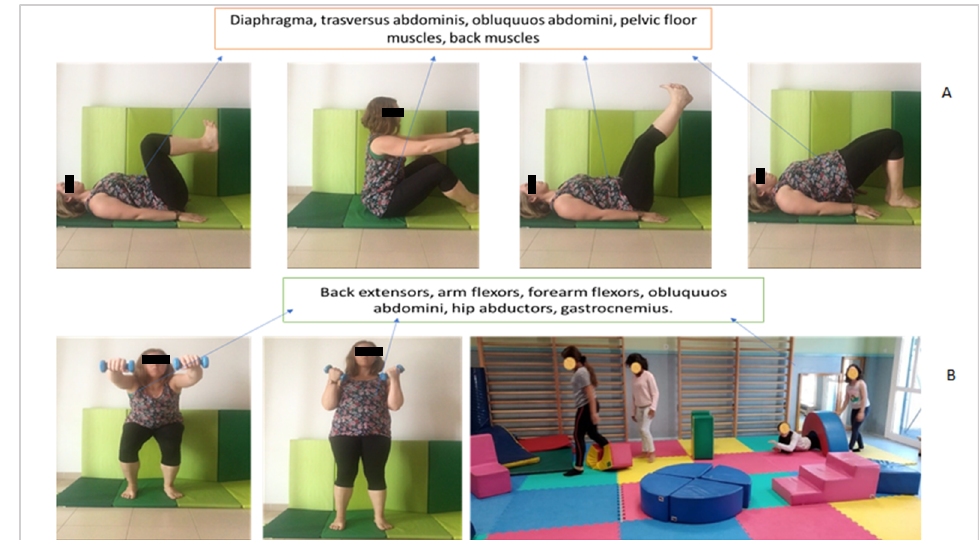
Figure 3. Pilates method and therapeutic exercise training with the involved muscles. Part ( A ) shows the Pilates exercises, each exercise is performed for five minutes with 3 sets of 10 reps each (20 minutes of training). For the different exercises, the chin is placed low, the shoulders back and down; the child activates the transverse and pelvic floor. In the first exercise, the legs are kept at 90º; then, maintaining the posture, the child works the whole body globally, focusing on the abdomen and legs. In the second exercise, the child rolls down to the sacrum and focuses on the abdomen. In the third exercise, the child works the whole body globally, focusing on the abdomen and legs. Part ( B ) shows the application of 10 minutes of therapeutic exercise: 2 exercises with dumbbells (5 minutes) with 15 reps for each exercise, finishing the training with 5 minutes of an exercise circuit combining actions such as jumping, dragging, running, going up and down the stairs, throwing balls, and other games.